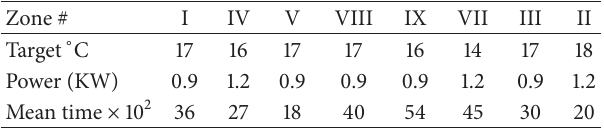
Table 3: Parameters used in cascade movement scenario.